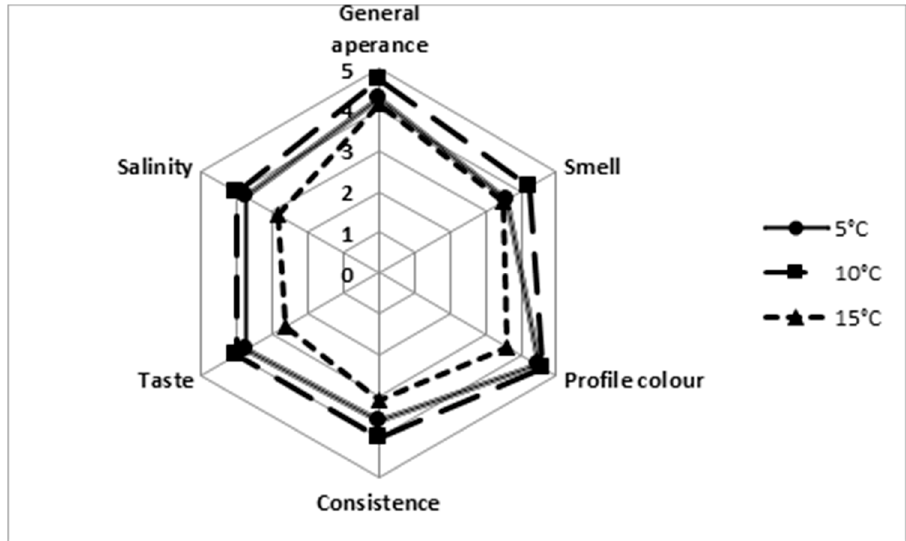
Figure 2. Sensory evaluation scores of Koryci ń ski cheese ripened in various conditions.